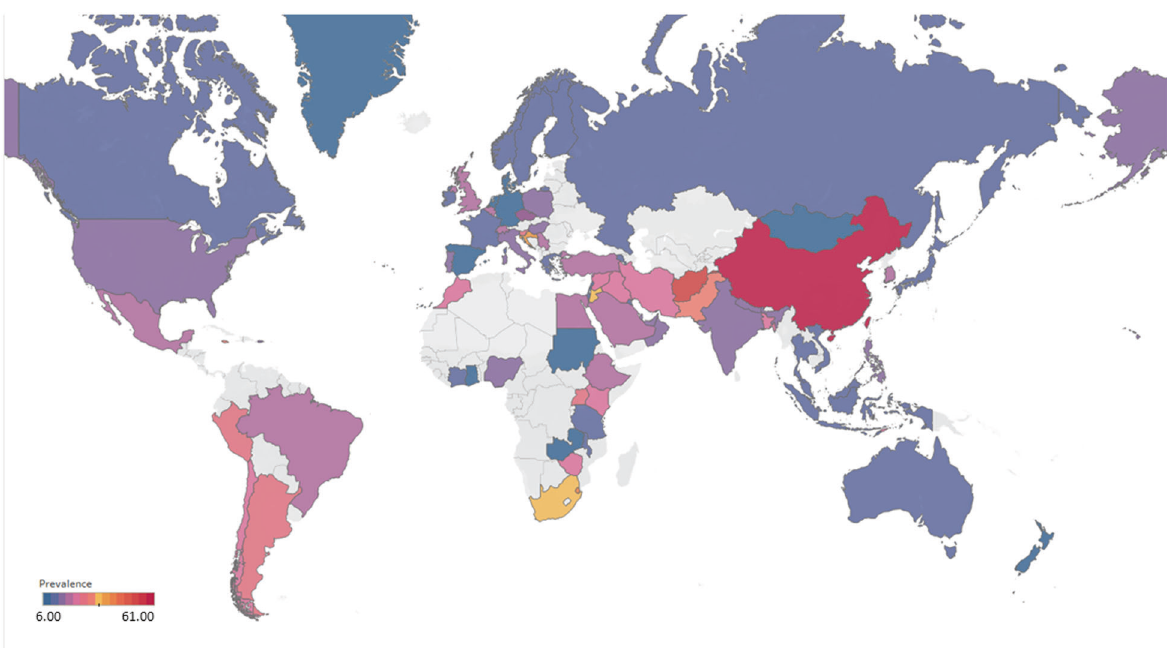
Fig. 2 Global prevalence of postpartum depression. (Unbalanced prevalence of postpartum depression was observed between different continents, countries and